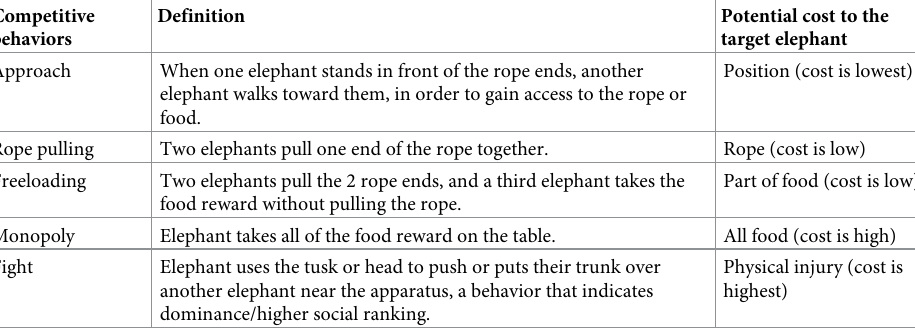
Table 1. Competitive behaviors of elephants and behavior